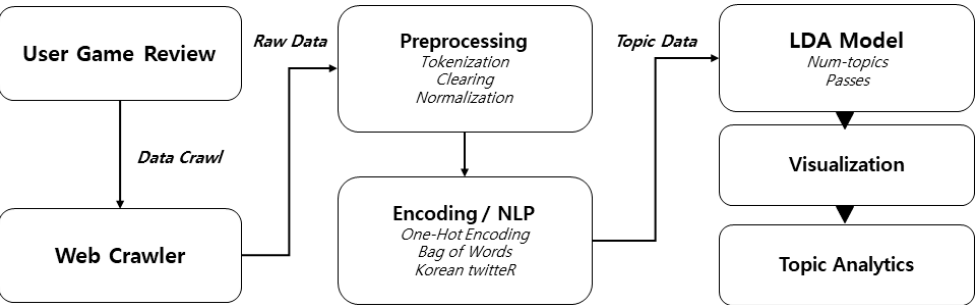
Figure 2. Mobile RPG data analysis.